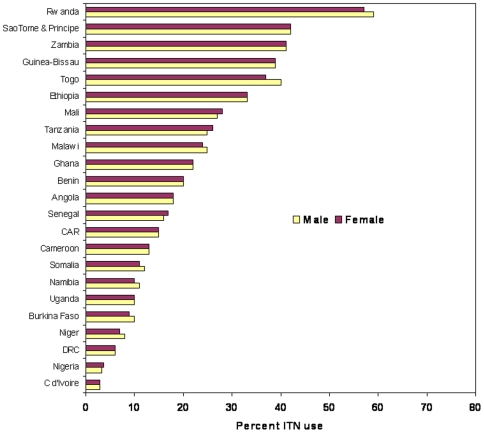
Equity among male and female children sleeping under an ITN.Percent male and female children under-5 years of age sleeping under an ITN the previous night, national surveys between 2006 and 2008. All country male-to-female rates are similar with no statistically significantly differences (P-value>0.05).